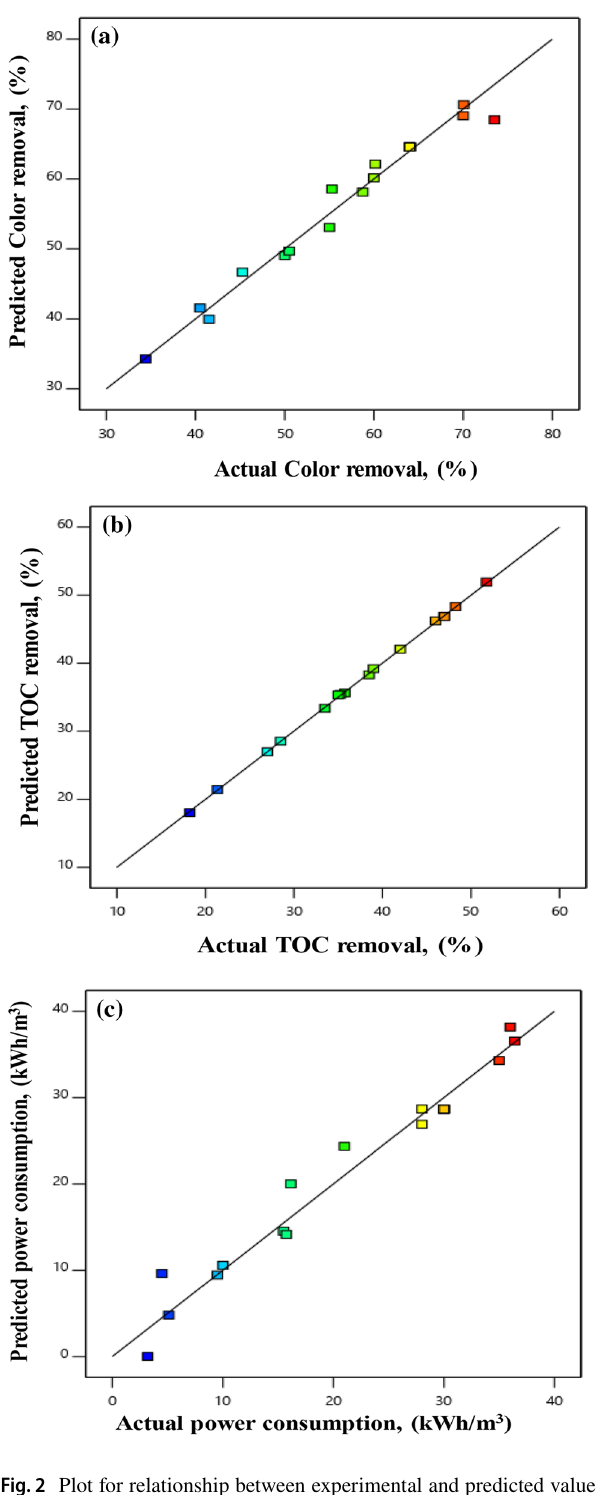
Fig. 2 Plot for relationship between experimental and predicted value for a % color removal, b % TOC removal and c power